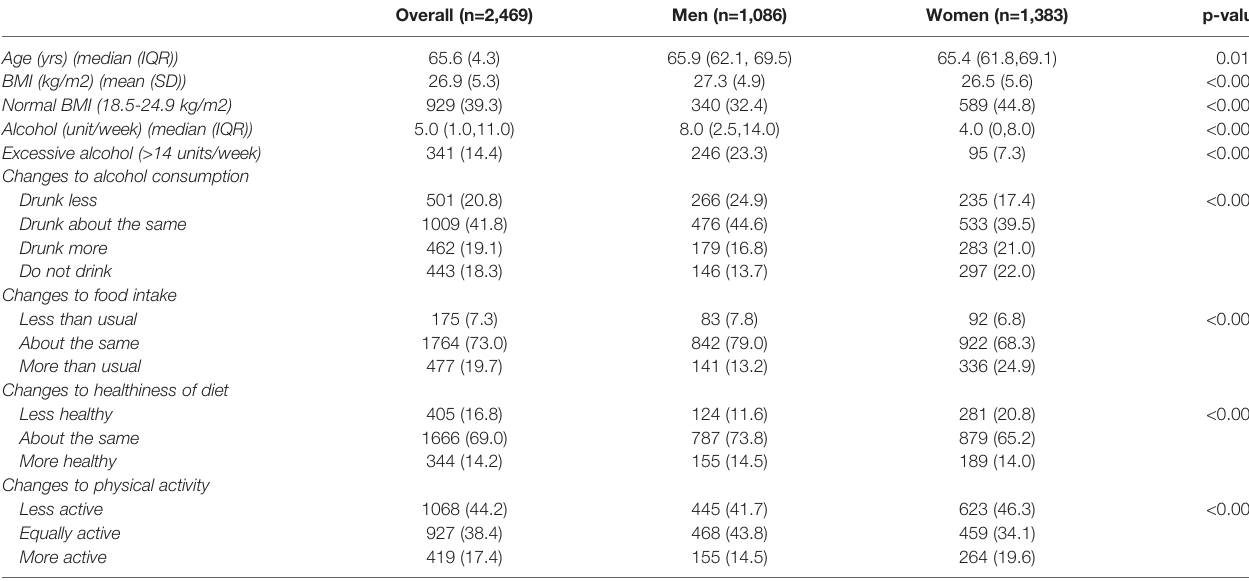
TABLE 2 | HEAF participants ’ characteristics and self-reported lifestyle changes compared to pre-pandemic